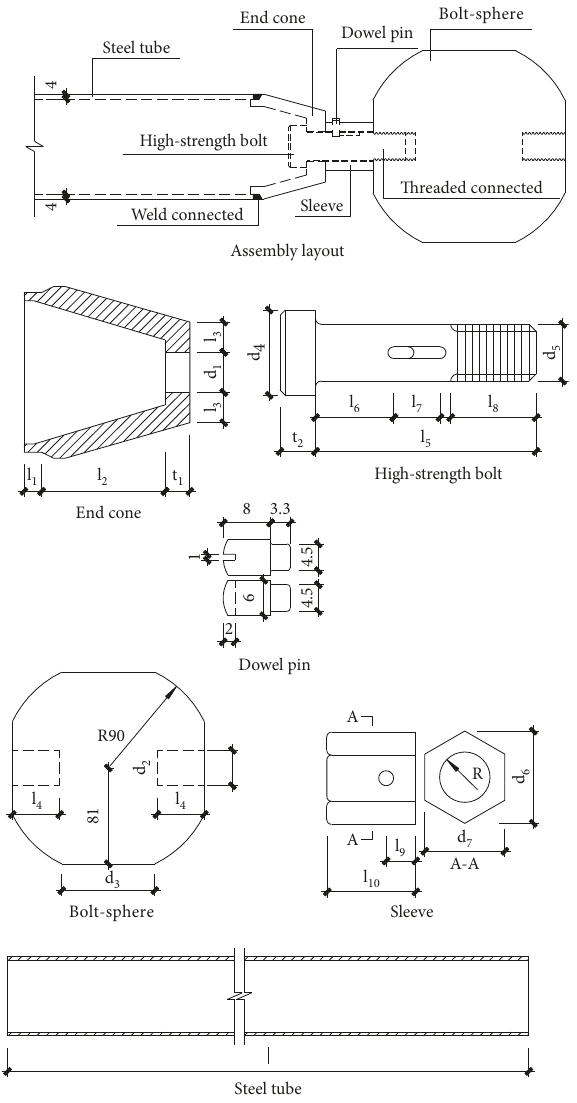
Figure 3: General test details. Table 2: Geometrical parameters of specimen corresponding to Figure